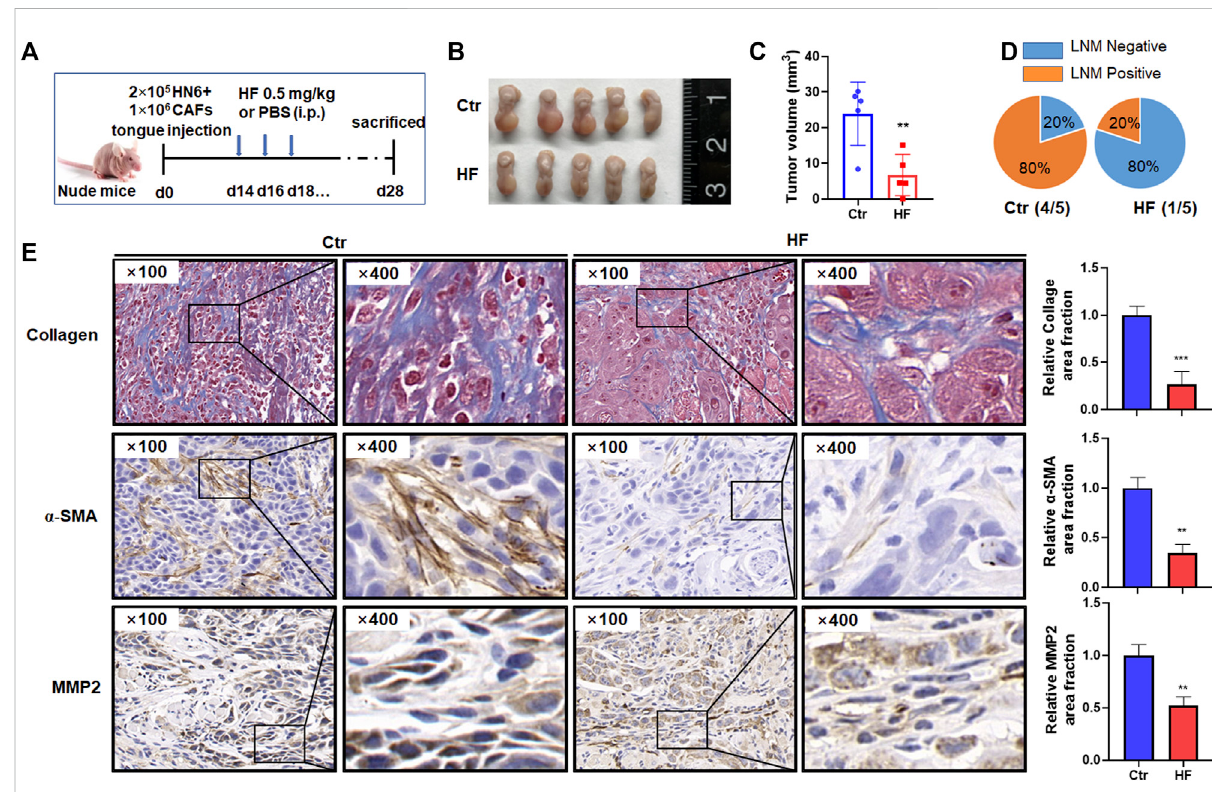
FIGURE 6 Halofuginone decreased tumor growth, LNM, CAF population, MMP2 expression and collagen deposition in vivo . (A) Experimental design for the in vivo study. Female Balb/c nude mice (4 – 6 weeks) successfully established tongue tumor were randomly divided into two groups: the control group (PBS, n = 5) and the HF treatment group (n = 5). The treatment group was intraperitoneally injected with 0.5 mg/kg HF every other day for 14 days. Tumor measurement (B,C) and LNM percentage (D) were made after mice were sacri fi ced on day 28th. (E) Masson staining was conducted todeterminethecollagendepositionintumorstroma.Immunohistochemistrywasusedto evaluatethe α -SMAandMMP2 proteinlevels. **: p < 0.01, ***: p <